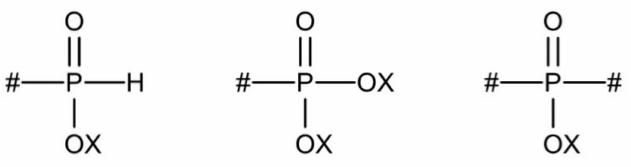
Figure 2. Common structures of phosphorus-containing units in polymers. Table 2. Summary of common phosphorus-based